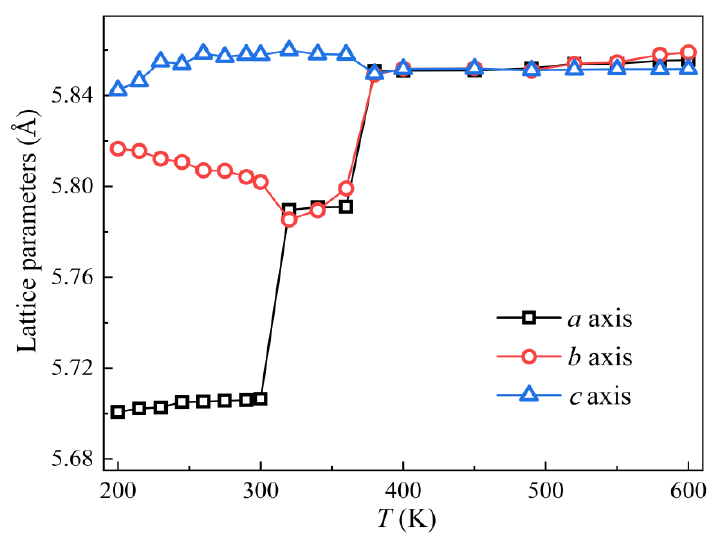
Figure 4. Changes in lattice parameters of cubic CsPbBr 3 along three crystallographic axes at different temperatures using the BV model.